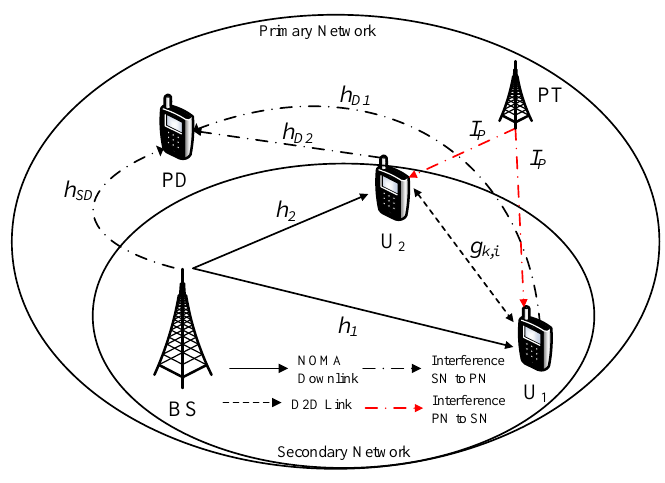
Figure 1. System model of CR-NOMA employing D2D